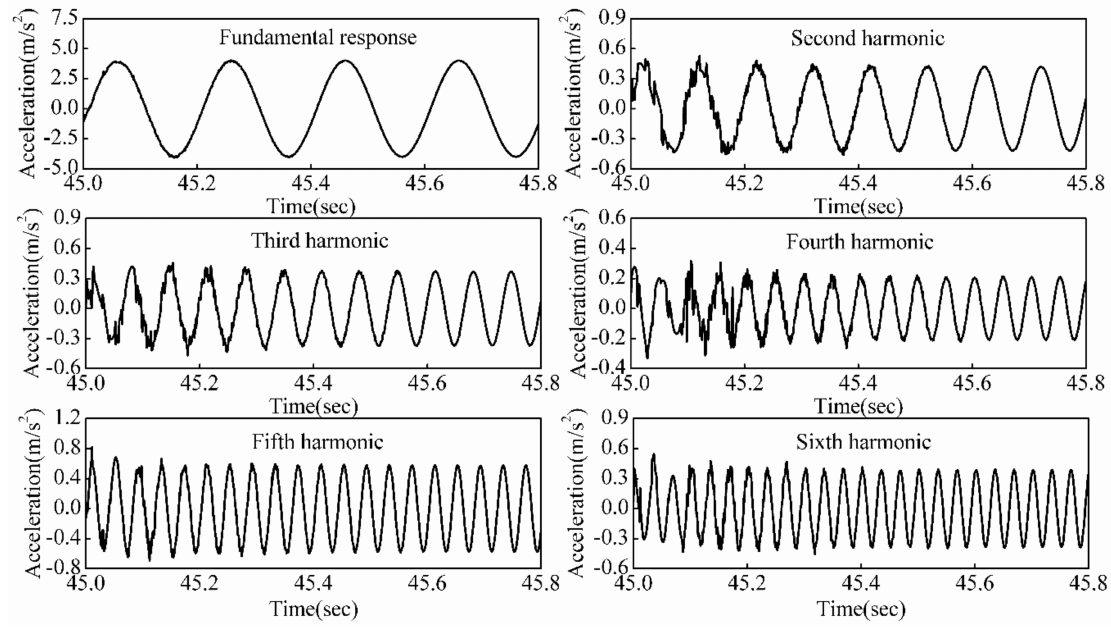
Figure 13. Estimation of each